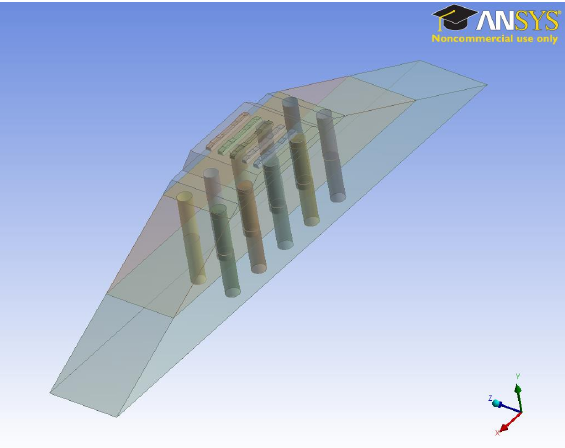
Figure 6. The model of the embankment with a geogrid and lime-cement